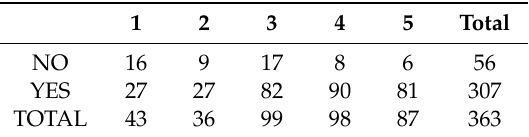
Table 6. Relevance of the cost of publication in the selection of the journal (1 to 5) compared with the increase in funding, as an initiative measure, in Open Access (YES / NO).